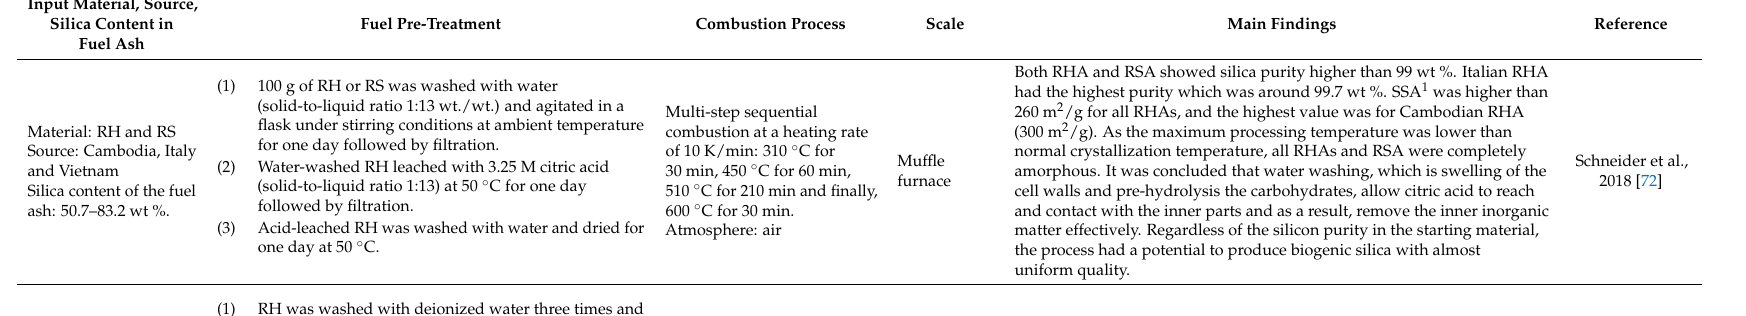
Table 5. Combined fuel pre-treatment and combustion to obtain pure biogenic silica from RH and